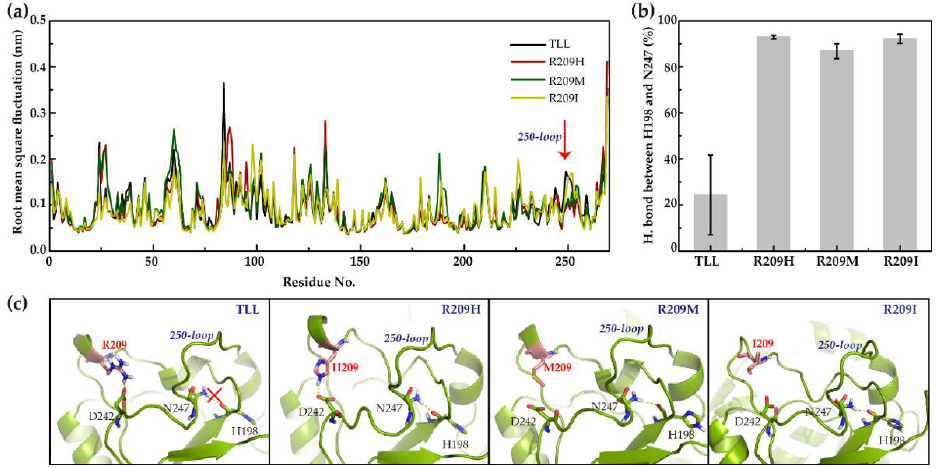
Figure 5. RMSF and hydrogen bonding interpretation of TLL and three R209 mutants. ( a ) Illustrates the root mean square fluctuation (RMSF) of TLL and the three R209 mutants during the simulations; ( b ) displays the hydrogen bond forming probability between H198 and N247 in the TLL and three R209 mutants during the entire simulations; ( c ) shows the structures of TLL, R209H, R209M, and R209I, respectively. Hydrogen bonding interaction and salt bridge interaction were labeled in yellow dash lines, residue 209 was labeled in red, and its carbon atoms are colored in salmon.